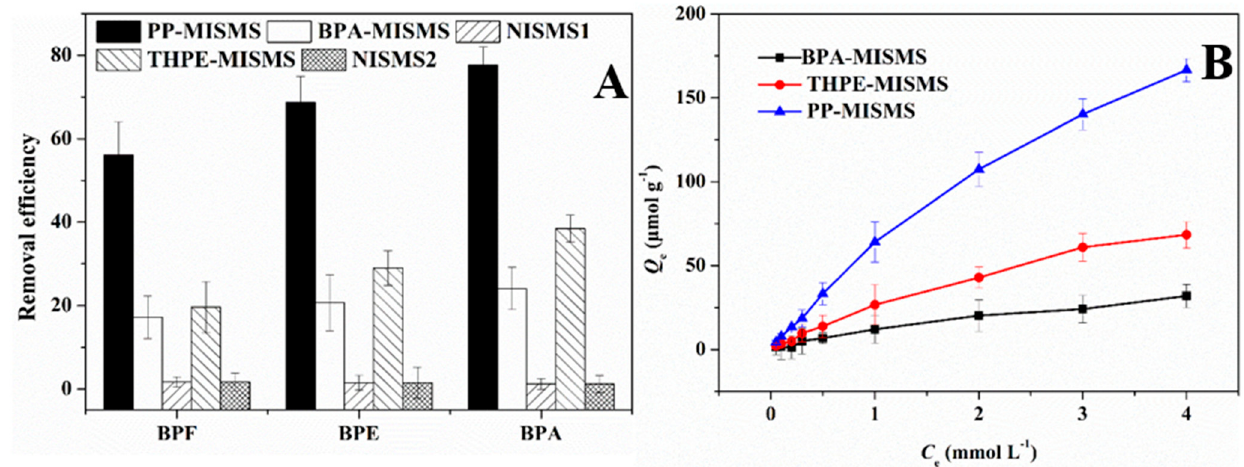
Figure 2. ( A ) The removal efficiency of MISMS prepared by different template molecules on BPs. ( B ) Adsorption isotherms of BPA on PP-MISMS, THPE-MISMS, and BPA-MISMS. The bars represent the mean value ± standard deviation ( n = 3).